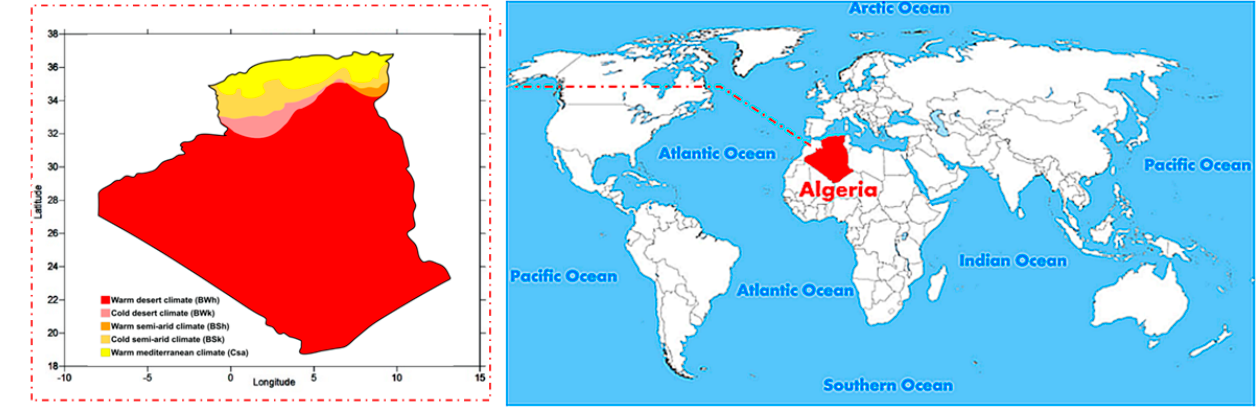
Figure 10. Algeria climatic map .